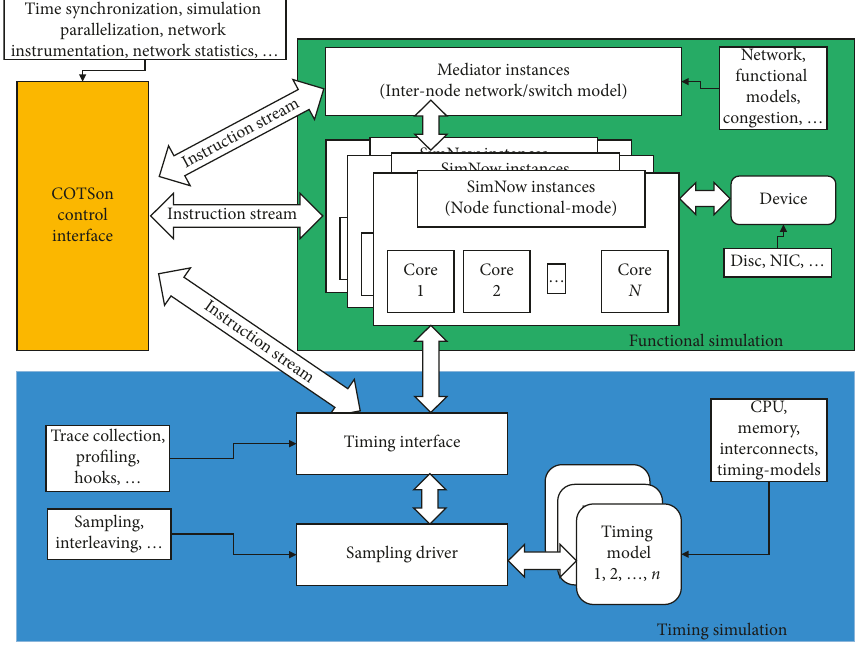
Figure 4: The COTSon simulation framework architecture [19, 45].